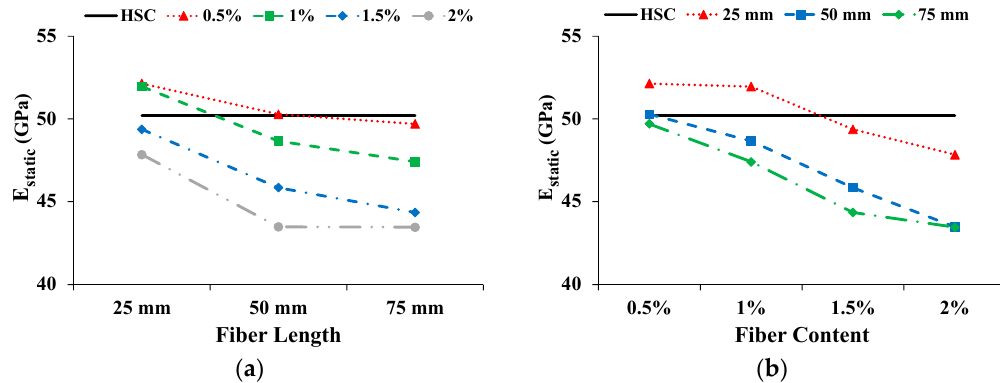
Figure 6. Influence on E static : ( a ) Fiber length; ( b ) Fiber content .